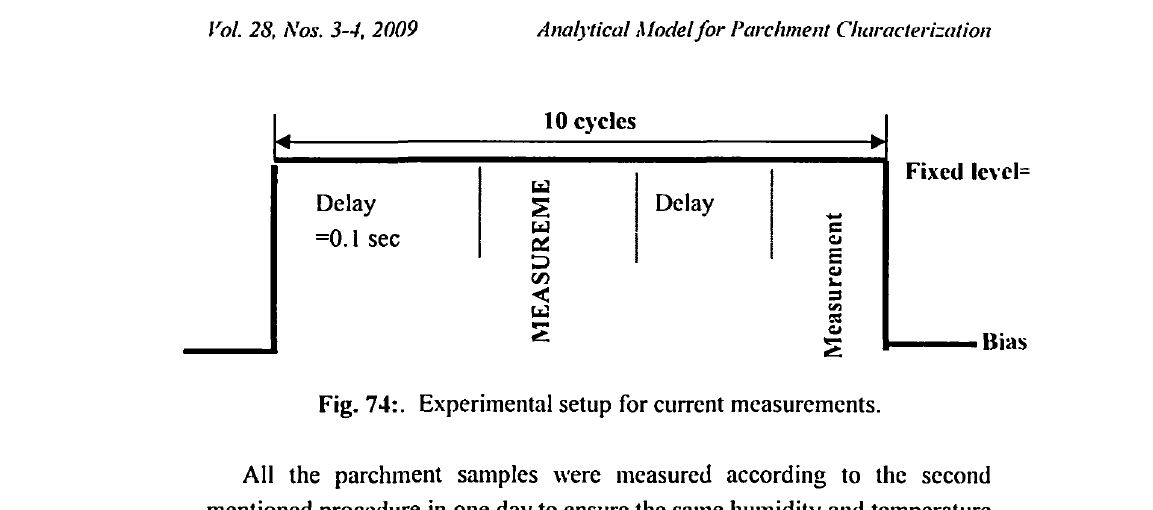
Fig. 74:. Experimental setup for current